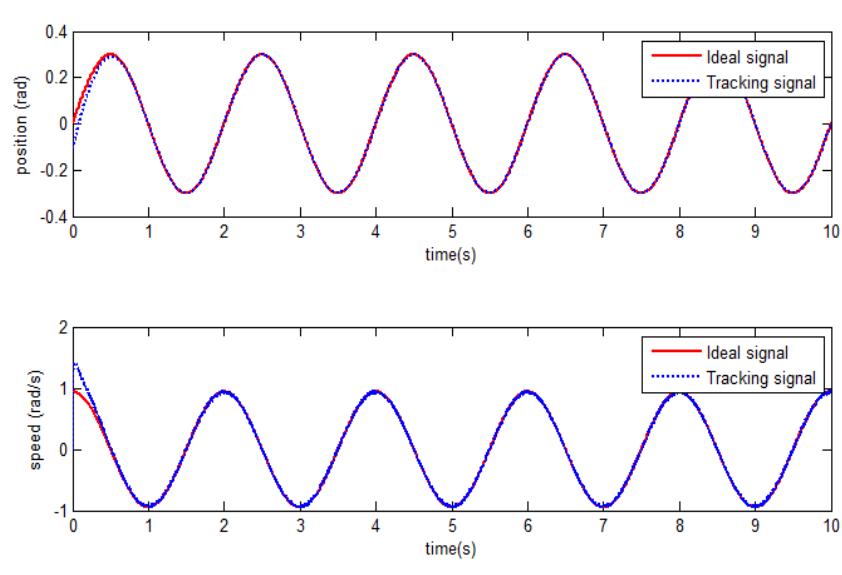
Figure 6. States of the ARA joint 2.